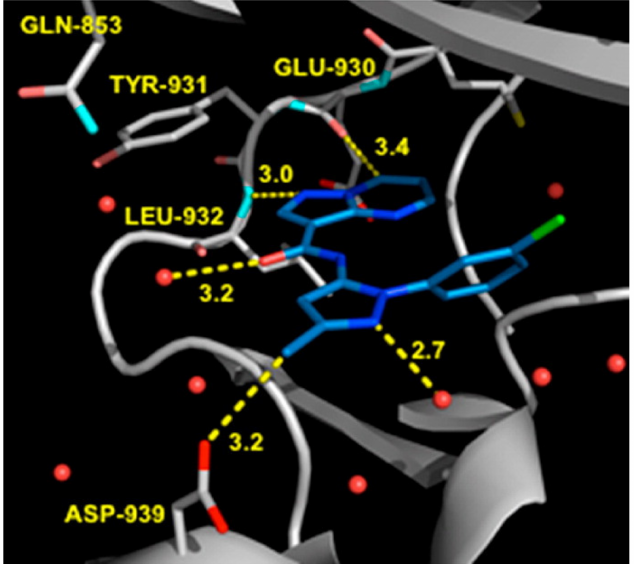
Figure 48. Co-crystal structure of 2-des-amino compound in the active site of the JAK2 kinase domain (2.3 Å). P-loop removed to allow a better view of the key active site interactions. Dashed lines = close contacts between ligand and protein with distances labeled in Å